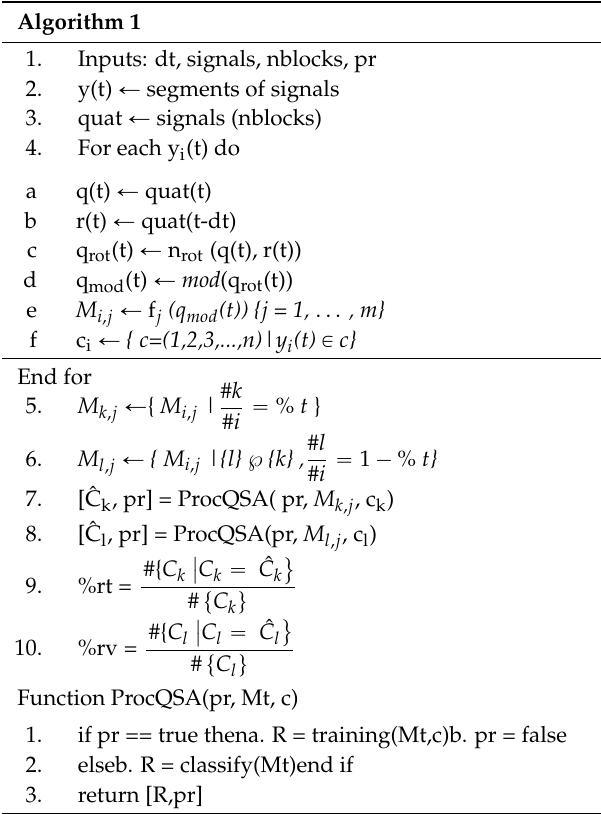
Table 2. QSA Method for training and classifying EEG